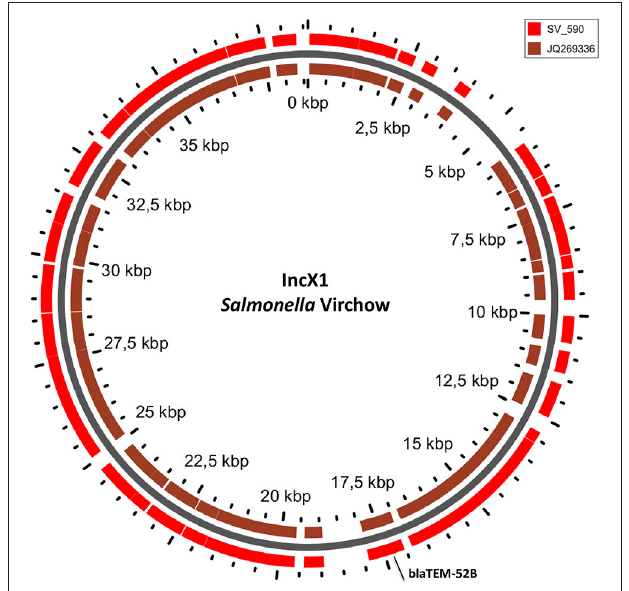
FIGURE 5 | BLAST ring of IncX1 plasmid homolog of Salmonella Virchow and a reference plasmid JQ269336. Blast ring was created with GView. The middle ring is the reference plasmid, around which a BLAST lane of the plasmid in S. Virchow is shown. The location of antibiotic resistance gene is indicated outside the